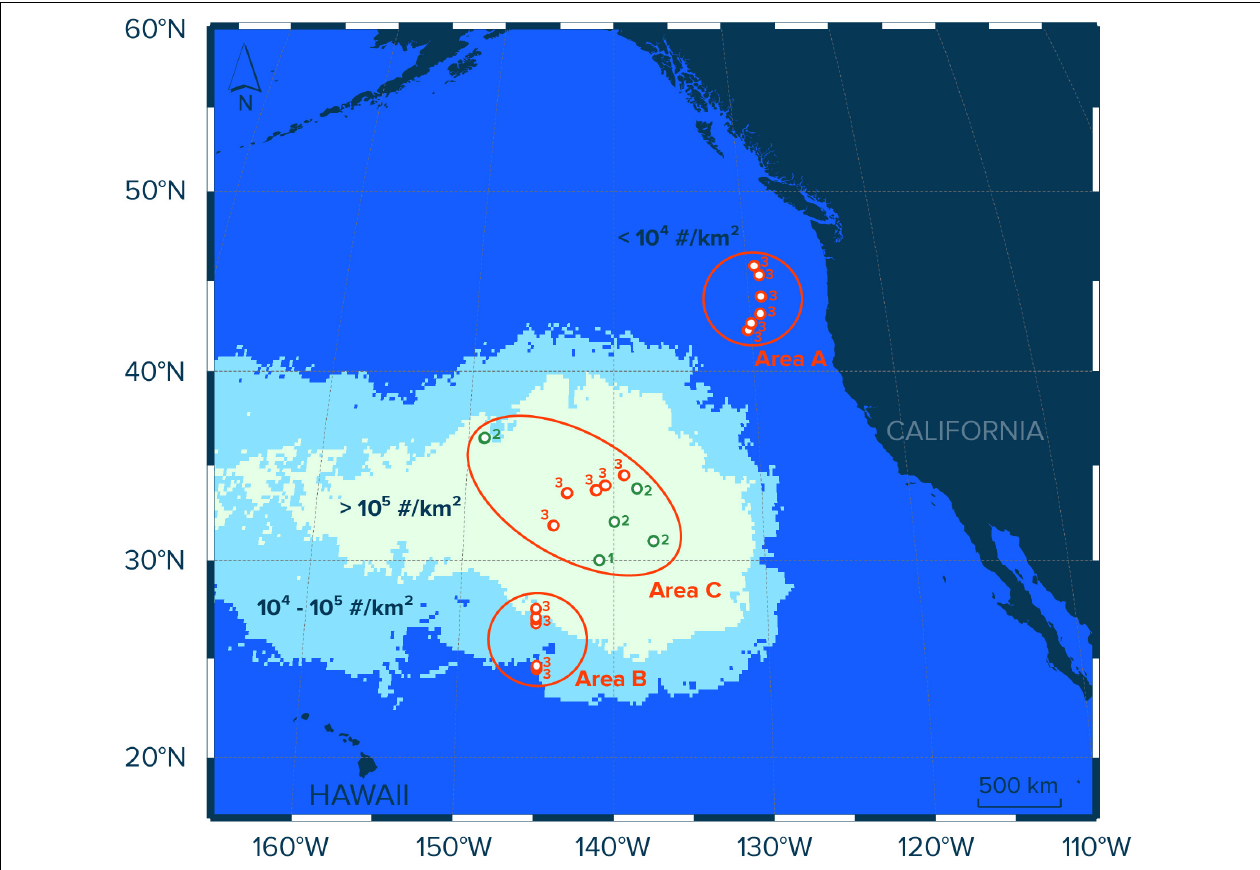
FIGURE 1 | Study area in the eastern North Pacific Ocean and contours of modeled numerical concentrations (#/km 2 ) of floating plastic debris ( > 0.5 mm) in the region as estimated by Lebreton et al. (2018). Red circles indicate Manta trawl deployment locations during the NPM3 Expedition (November/December 2019), while green circles indicate trawl locations during the Mega Expedition (August 2015). Circle numbers indicate the number of Manta trawl deployments at the sampling location. Samples in Area A ( n = 18) were collected in waters with modeled concentrations of floating plastic debris of < 10 4 #/km 2 , samples in Area B ( n = 12) were taken in waters with modeled concentrations of plastic of between 10 4 and 10 5 #/km 2 , and samples collected in waters with modeled concentrations of floating plastic debris exceeding 10 5 #/km 2 were assigned to Area C ( n =